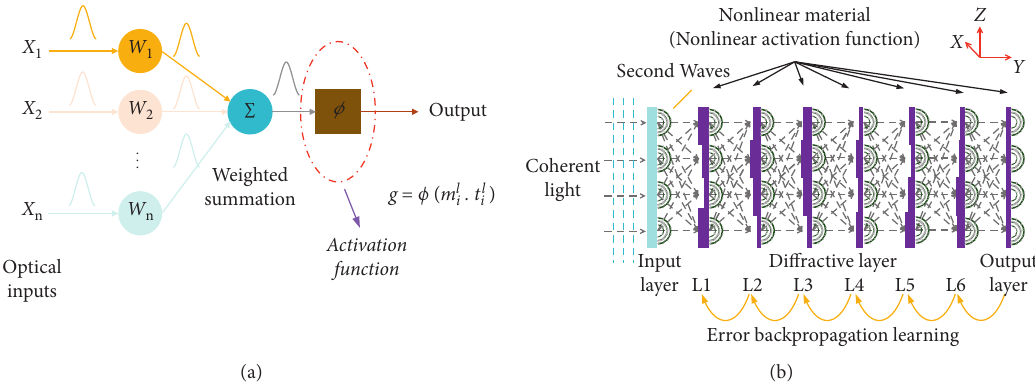
Figure 3: (a) Schematic diagram of neurons in the diffraction mode with nonlinear activation. (b) N-D 2 NN blueprints with optical nonlinear